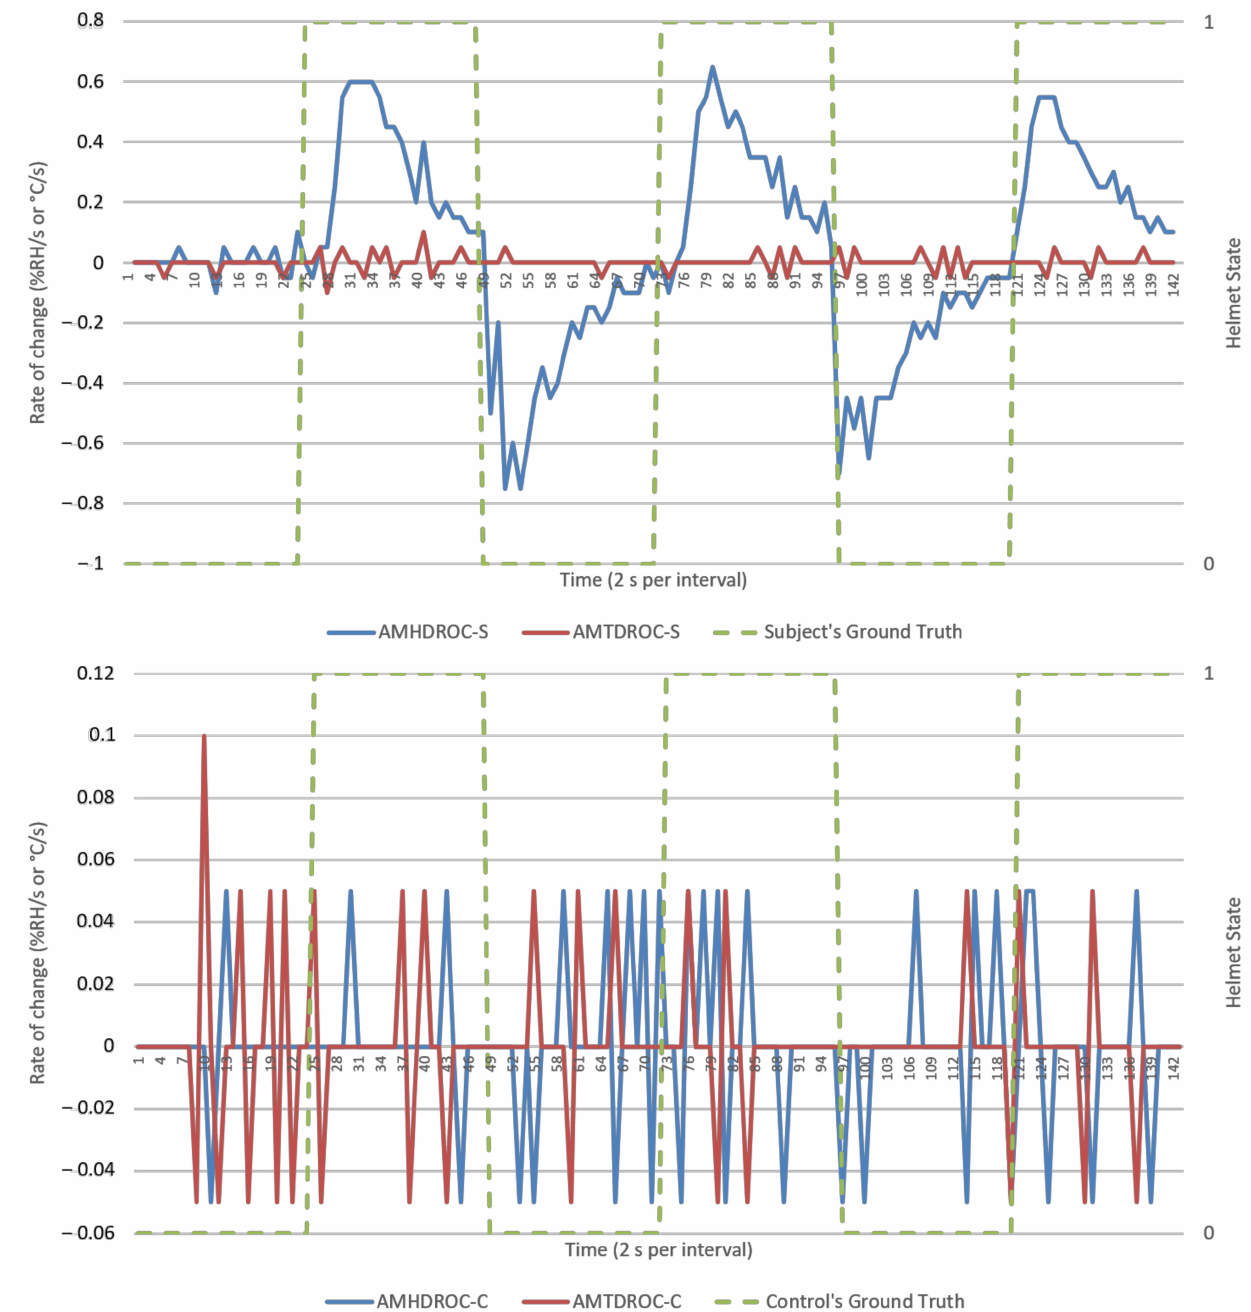
Figure 11. Ambient-microclimate difference’s rate of change (AMDROCs) versus time (2 s per interval) from a typical NM run, human subject ( top ), and experiment control ( bottom